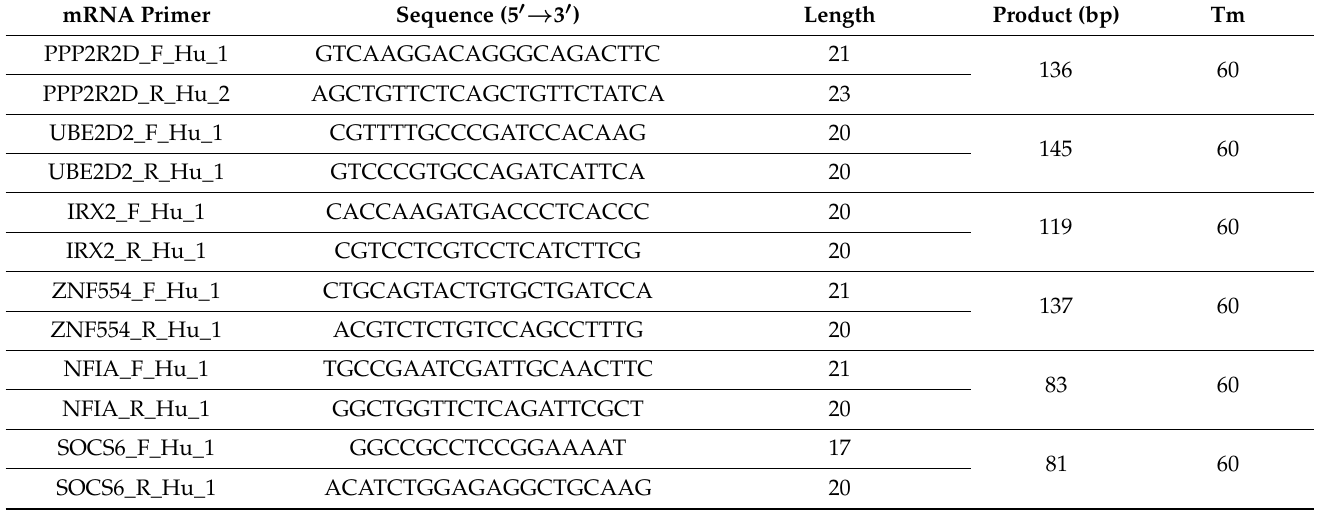
Table A2. RT-qPCR primers for mRNA gene expression